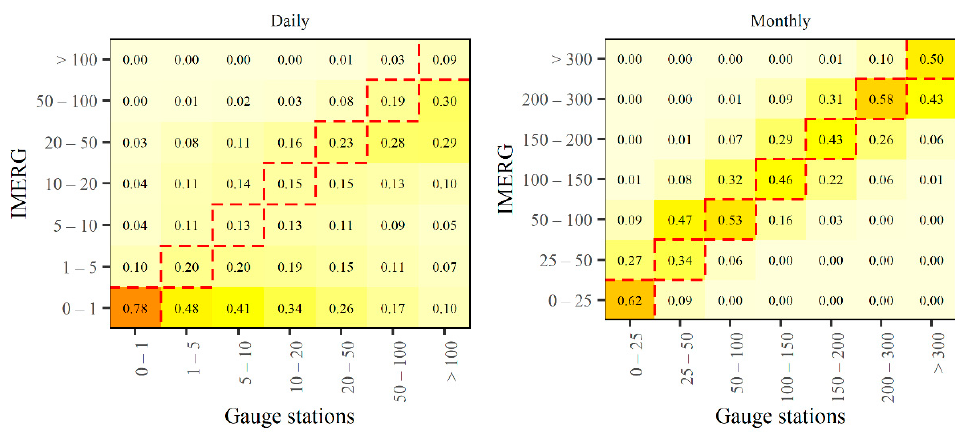
Figure 7. Confusion matrix for different precipitation ranges at daily and monthly scales.